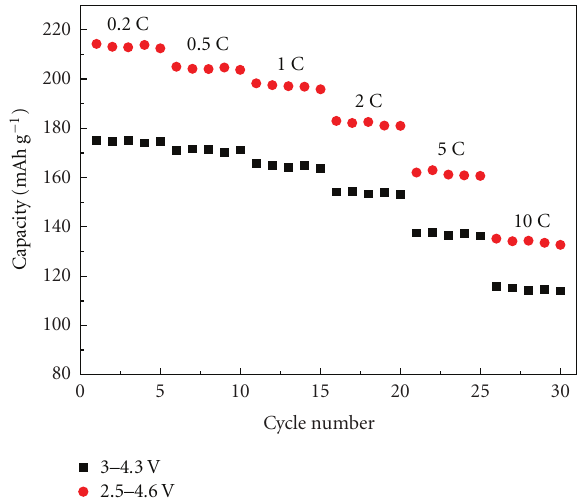
Figure 11: Cycle performance of Li/Li[Ni 0 . 5 Mn 0 . 3 Co 0 . 2 ]O 2 cell in the voltage range of 3.0–4.3 V and 2.5–4.6 V at various current den- sities at 25 ◦